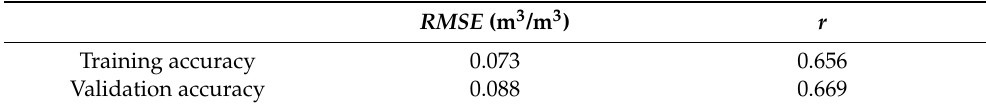
Table 2. Fitting accuracy of MODIS surface soil moisture retrieval